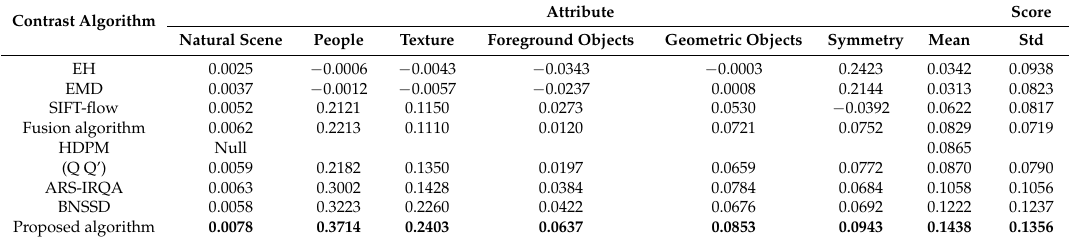
Table 5. Classification comparing KRCC of multiple evaluation methods in database